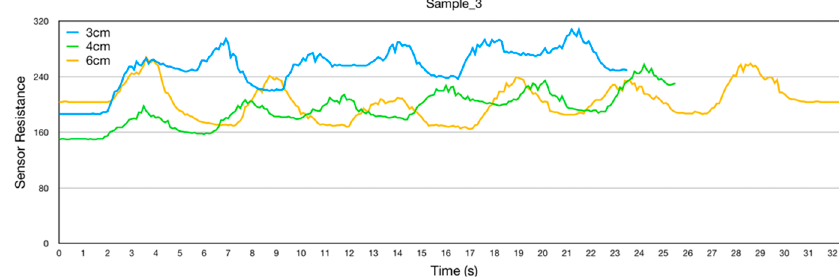
Figure 13. Results of sample